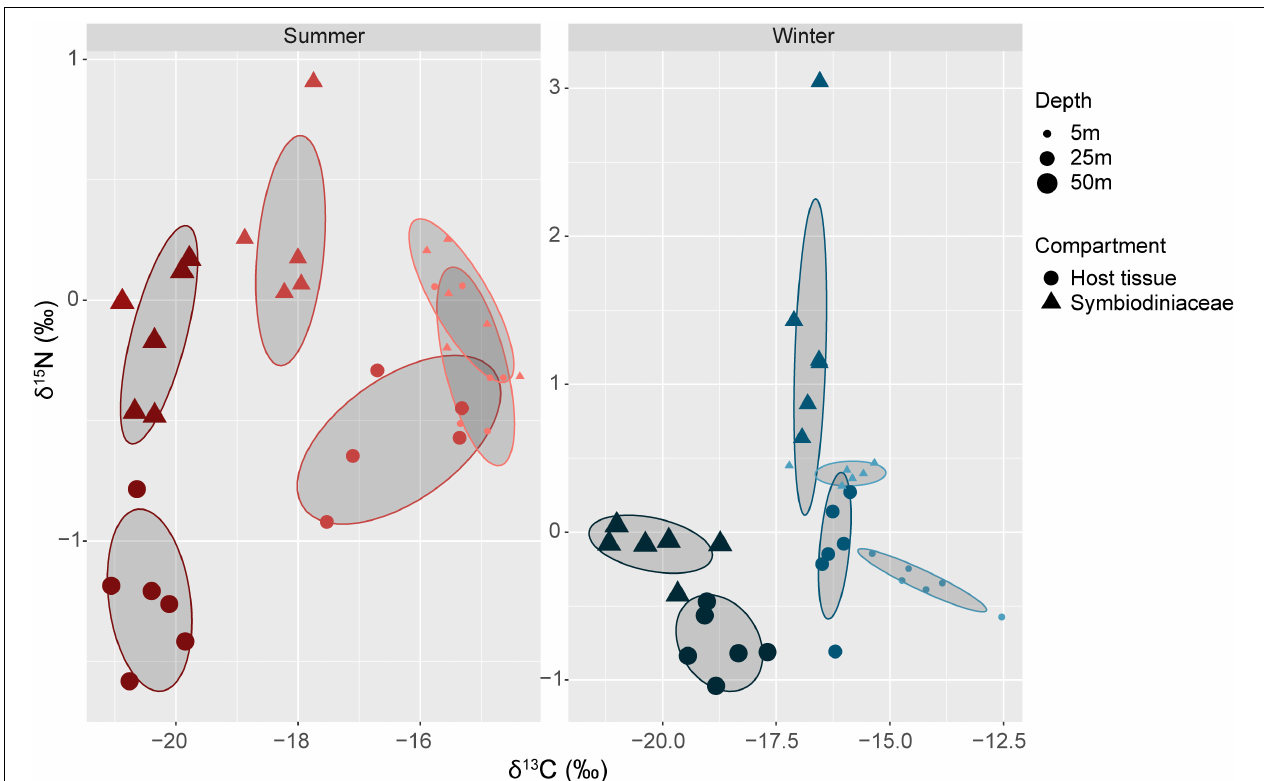
FIGURE 3 | Natural δ 15 N and δ 13 C signature of the coral host and Symbiodiniaceae from Stylophora pistillata corals collected along a depth gradient (5, 25, and 50 m) in summer and winter. Note the different scaling of the δ 15 N and δ 13 C axes between summer and